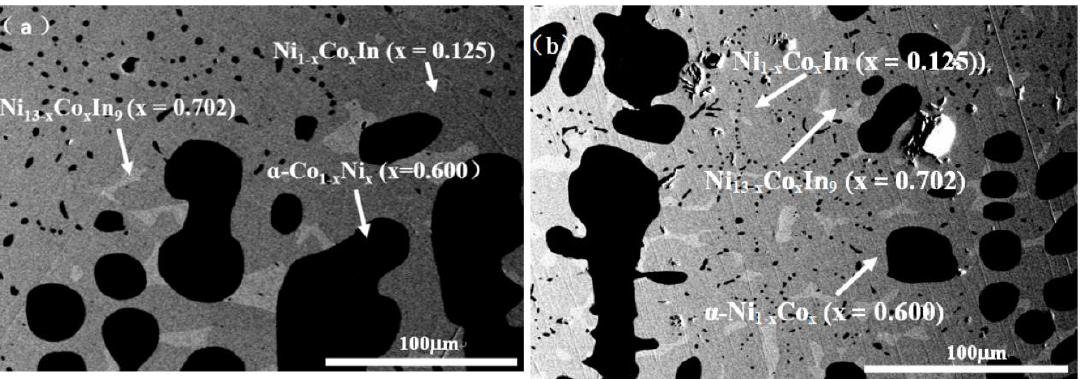
Figure 3. BSE micrograph of samples ( a ) No. 3(Co25Ni50In25) and ( b ) No. 4 (Co22Ni52In26).